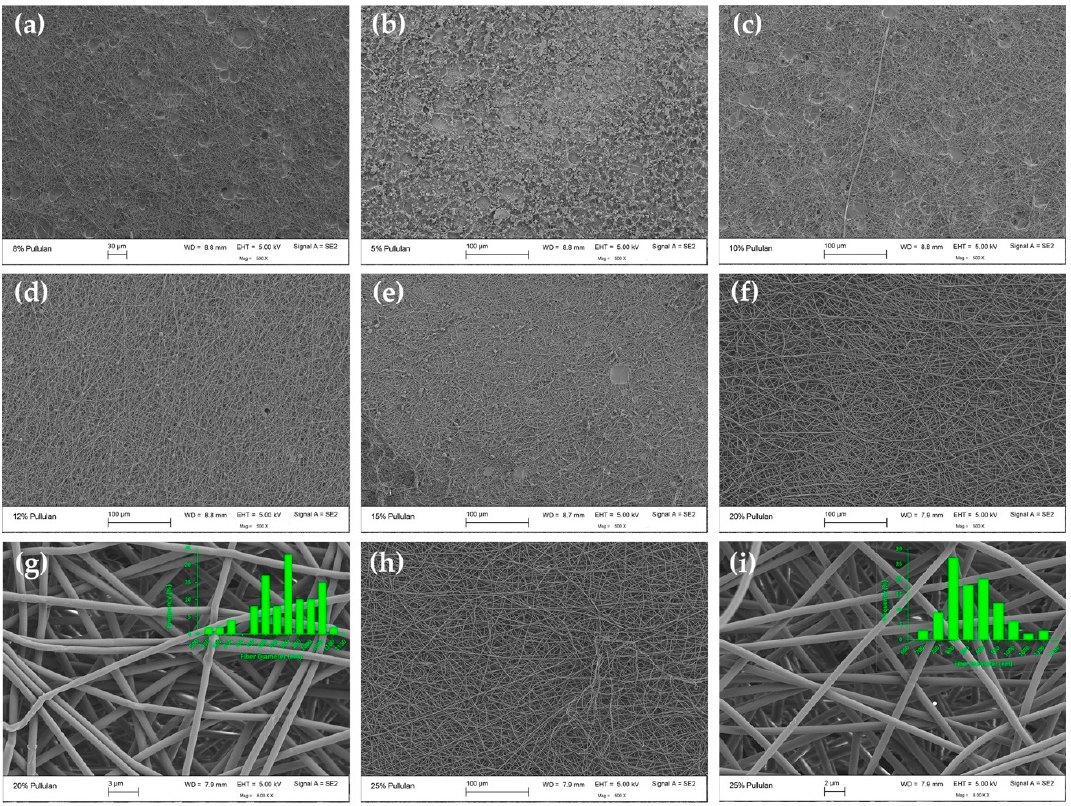
Figure 4. SEM images and diameter histograms of pullulan electrospun fibers at ( a ) 5, ( b ) 8, ( c ) 10, ( d ) 12, ( e ) 15, ( f ) and ( g ) 20 and ( h ) and ( i ) 25% (w/v). Fiber size distributions are only presented for smooth and bead-free spunfibers.